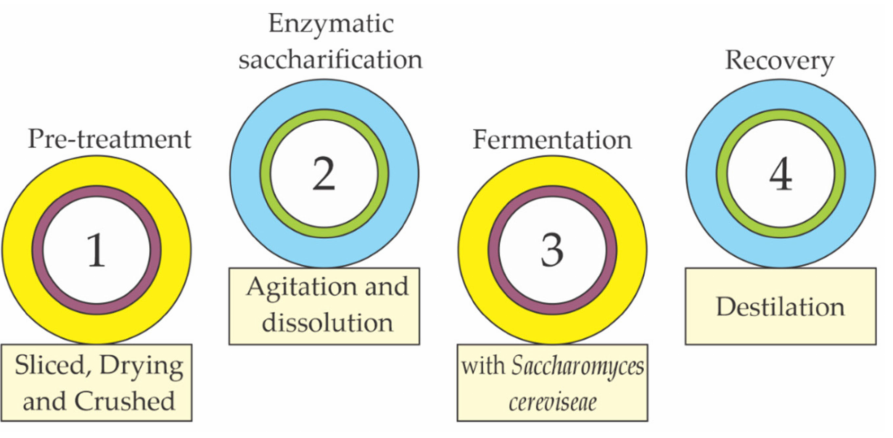
Figure 6. Stages of the bioethanol production process. Adapted from